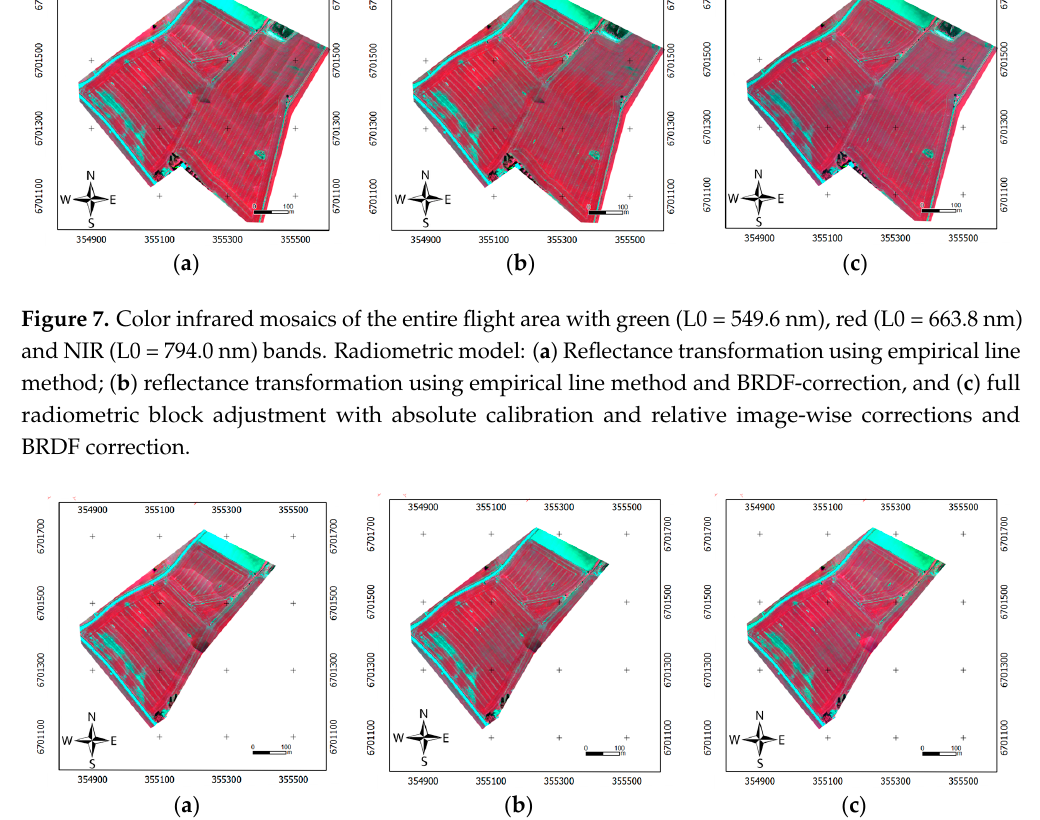
Figure 8. Color infrared mosaics of the area of flights f34 with green (L0 = 549.6 nm), red (L0 = 663.8 nm) and NIR (L0 = 794.0 nm) bands. Radiometric model: ( a ) Reflectance transformation using empirical line method; ( b ) reflectance transformation using empirical line method and BRDF-correction, and ( c ) full radiometric block adjustment with absolute calibration and relative image-wise corrections and BRDF